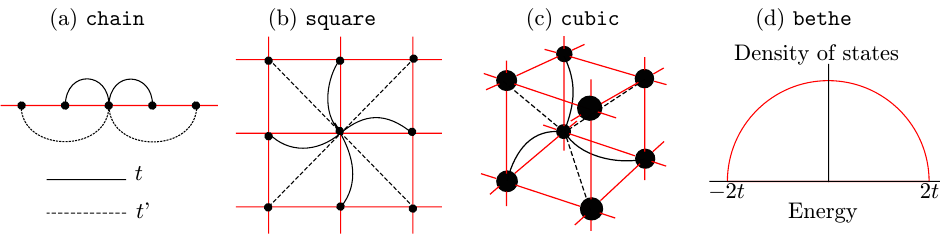
Figure 4: Predefined lattices in DCore. In the (a) chain , (b) square , and (c) cubic lattices, the solid (dotted) bonds indicate the transfer integrals t ( t (cid:48) ). For the (d) bethe lattice, a semicircular density of states with energy ranges [ − 2 t :2 t ] is